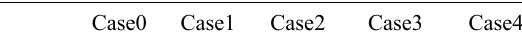
Table 11 – Weights of the external criteria with respect to the considered cases